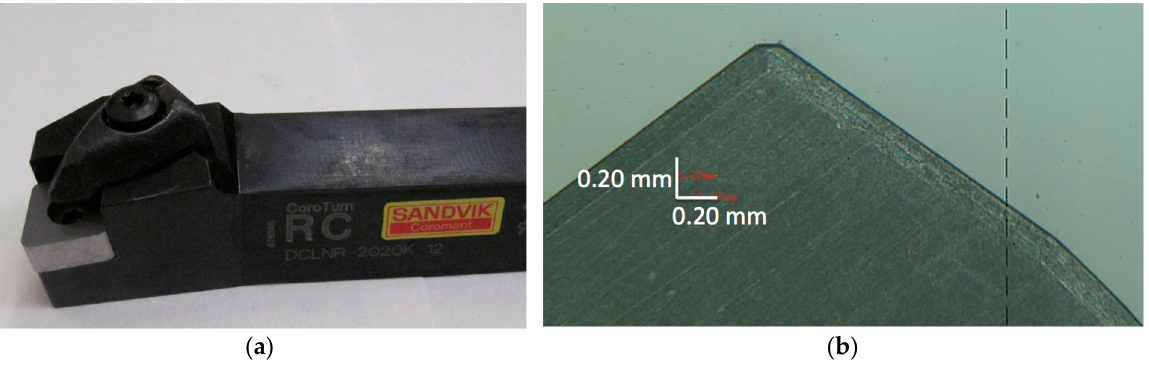
Figure 1. Experimental setup: ( a ) the holder with cutting insert; ( b ) insert CNGX1204L025-18AXA class 7015 with XCEL geometry.